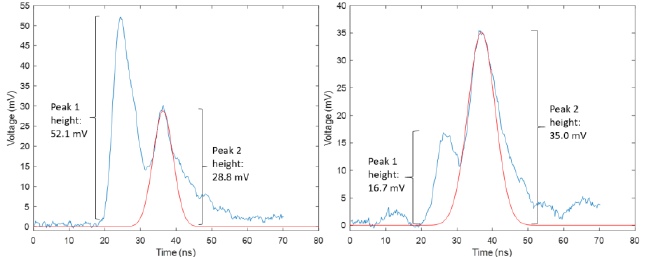
Fig. 9. Peak height determination for neutron double scatter candidate pulses. These pulses were produced by the pair of PMTs mounted to opposite ends of the camera along the x-axis of measurement. Taking the log ratios of the peak 1 and peak 2 heights yields scatter positions of +1.85 inches and -0.20 inches from the detector centerline in the x direction for scatters 1 and 2,